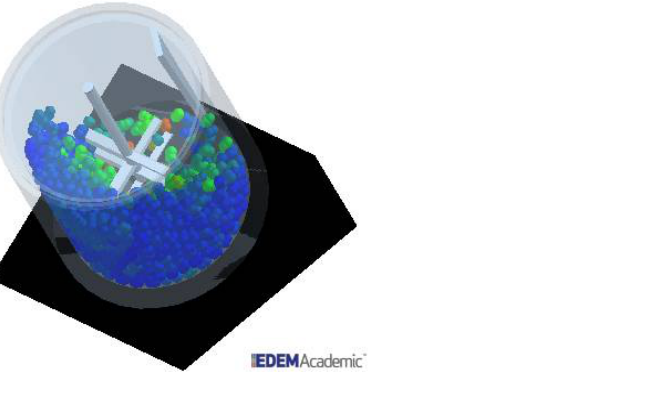
Figure 3. Snapshot of the simulation of the Eirich mixer using EDEM. The base of the device is inclined 32° in respect to the horizontal. Particles are coloured according to their velocity.